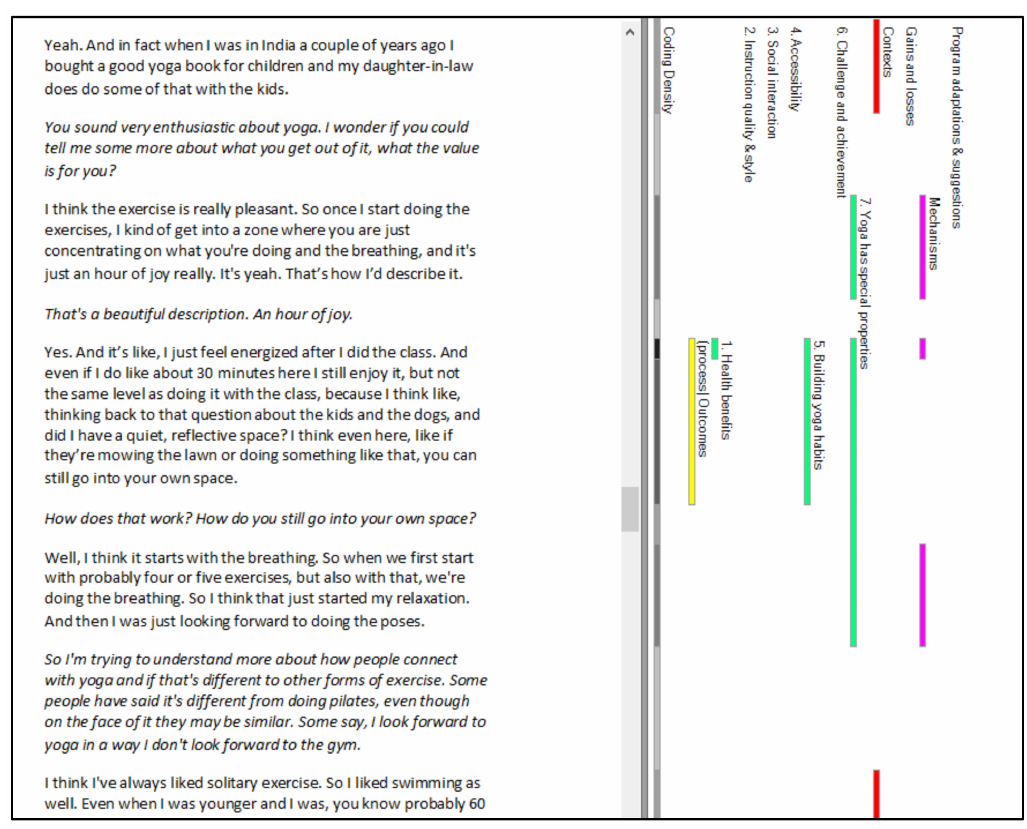
Figure 3. An example of coding to program theories + context, mechanism and outcome nodes in a participant